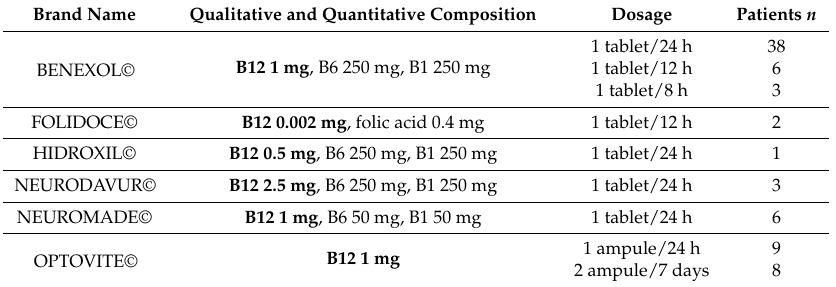
Table 2. Vitamin B12 oral treatment regimens used for treatment of B12